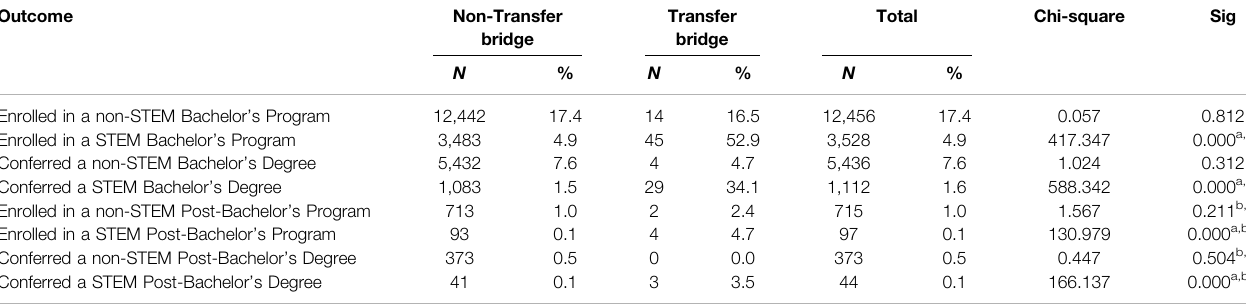
TABLE 4 | Results from USG data analyses.